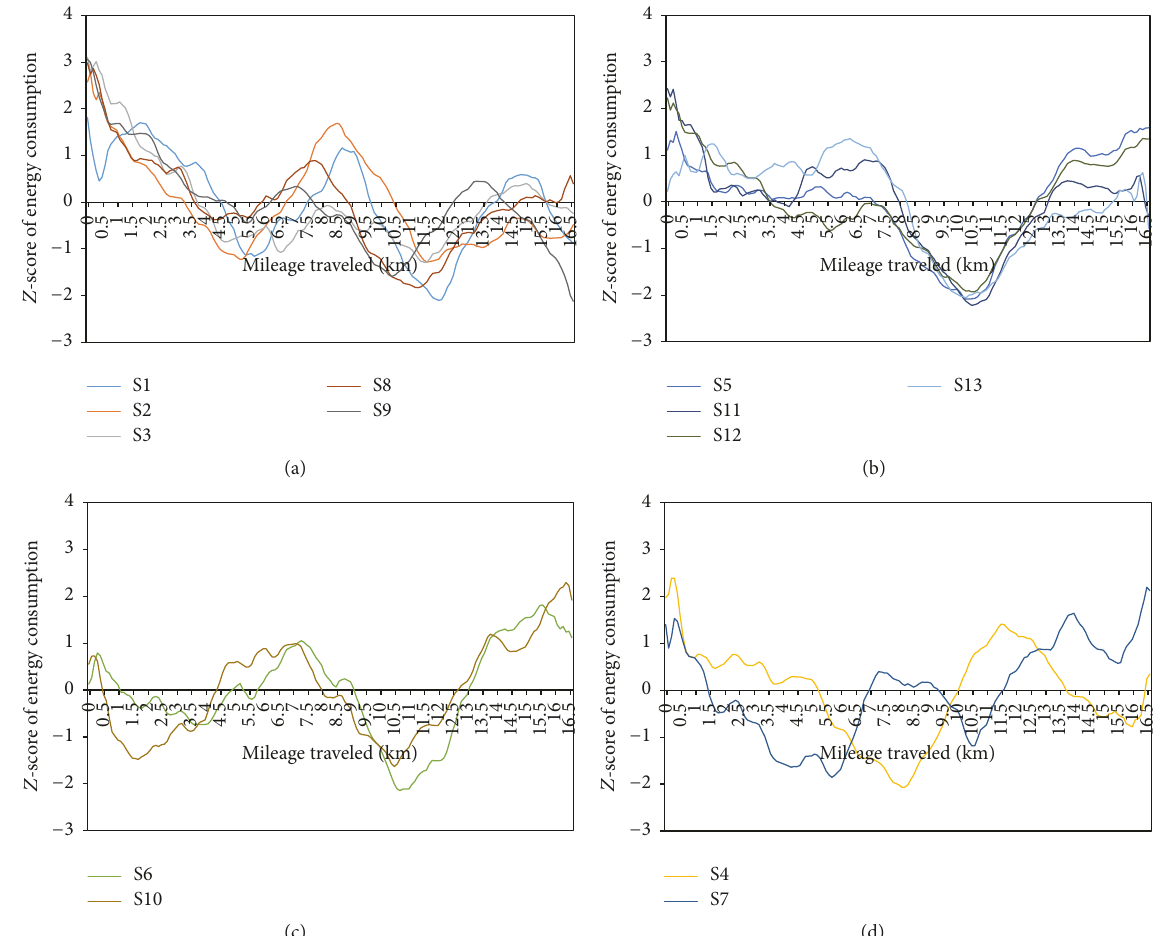
Figure 13: Energy consumption pattern for different clusters in smooth traffic condition: (a) Cluster A: S1, S2, S3, S8, and S9; (b) Cluster B: S5, S11, S12, and S13; (c) Cluster C: S6 and S10; (d) anomaly: S4 and S7.